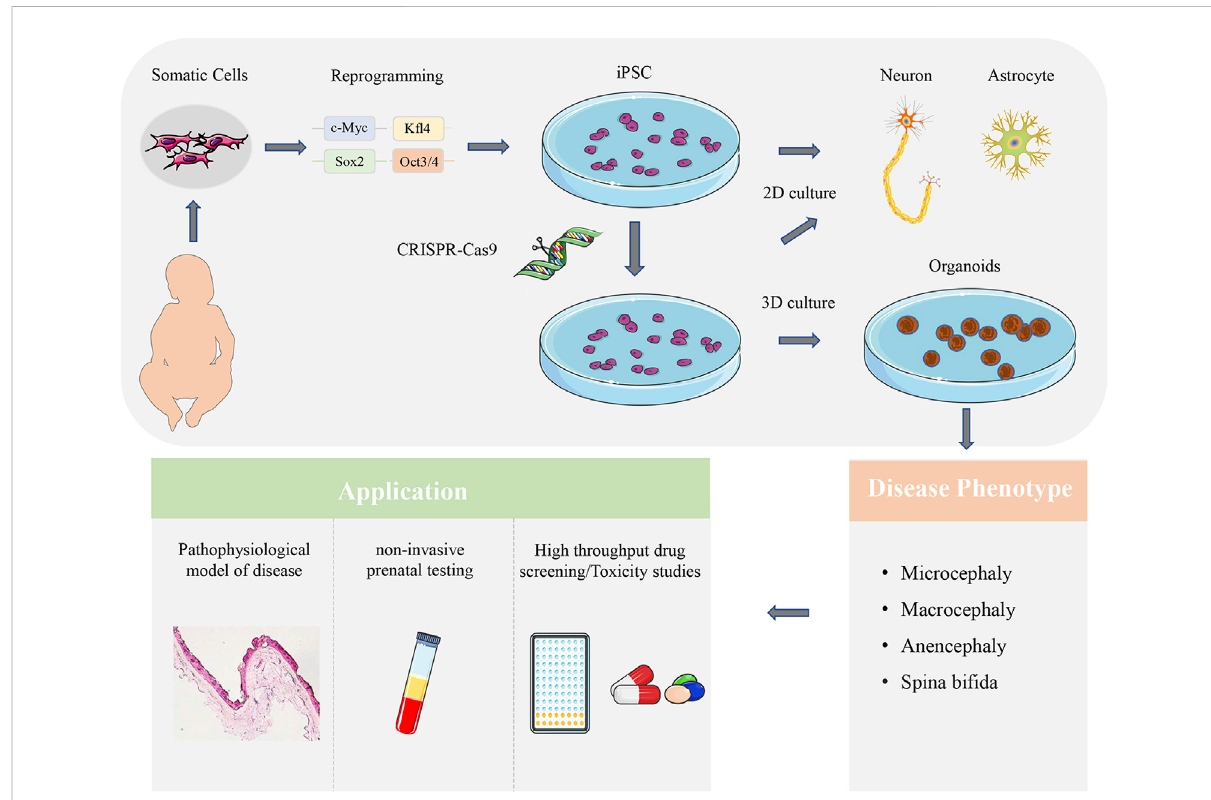
FIGURE 2 Application of brain organoid in CNSM. Patient-derived somatic cells reprogrammed into iPSCs can be differentiated into neurons and glial cells.The2Dco-culturemodelscananalyzetheinteractionofdifferentbraincelltypes.CRISPR-Cas9canalsobeusedtoeditiPSCs,andobservethe related characteristics of brain organoids, so as to determine the related mechanism of disease occurrence. Brain organoid can be used in different CNSM models to analyze the pathology of diseases, evaluate the ef fi cacy of newly developed compounds in drug screening and toxicity research, and make non-invasive prenatal testing